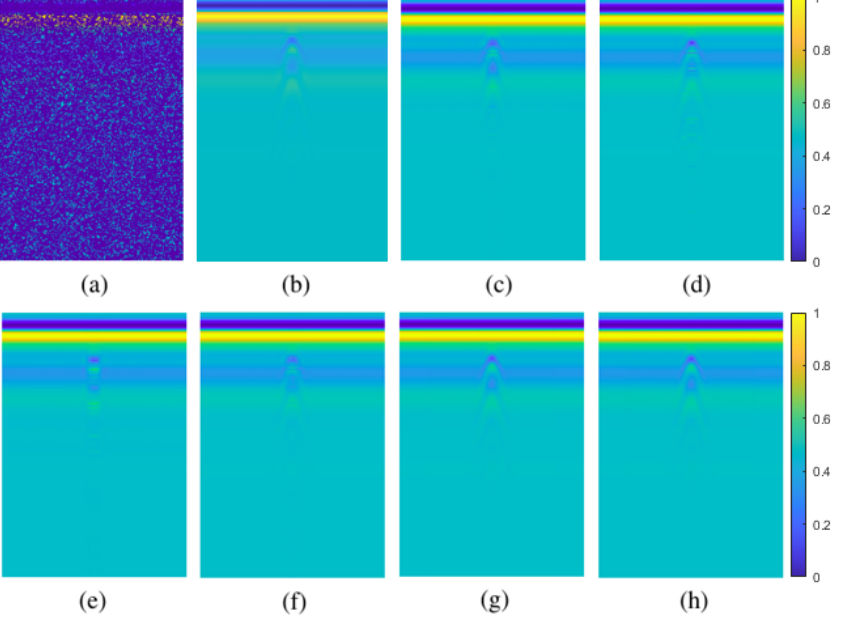
Figure 9. 80% pixel-wise missing data case for simulated data: ( a ) GPR image with missing entries, ( b ) original GPR image, recovered images by ( c ) GoDec, ( d ) NMC, ( e ) Lmafit, ( f ) NNM, ( g ) PEN-Net, ( h )